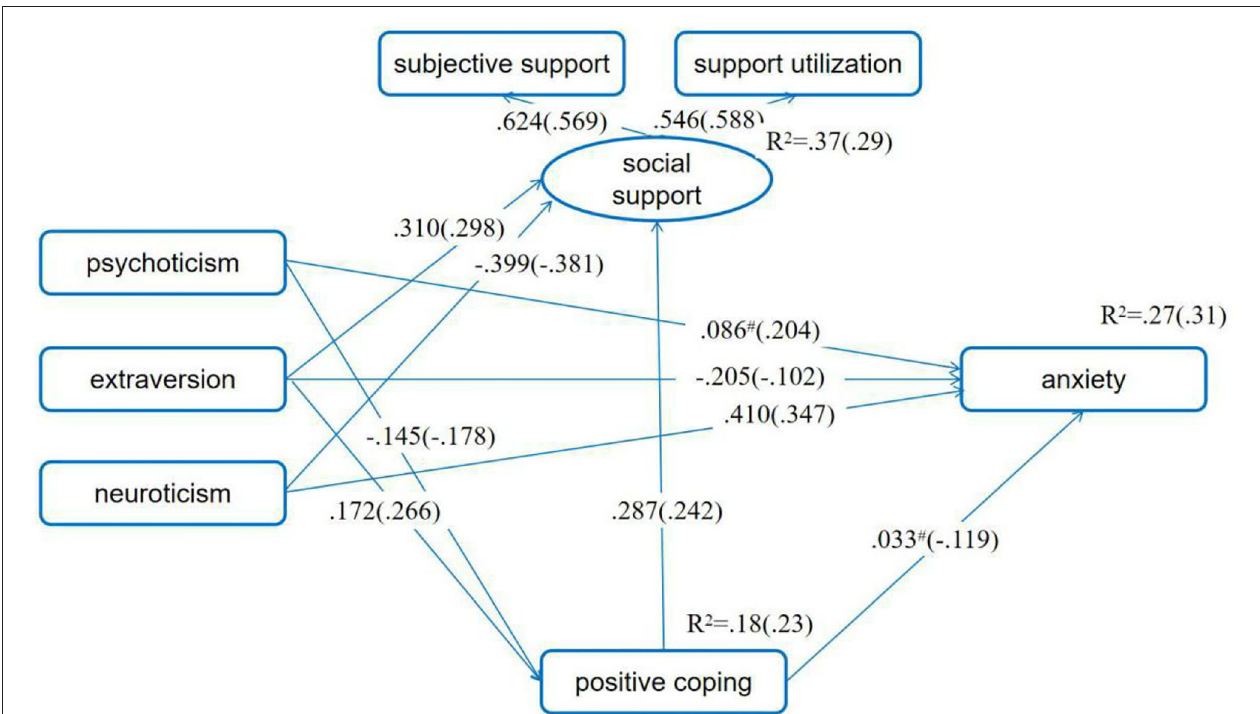
FIGURE 4 | SES as moderator in the mediating model of positive coping in the association between personality and anxiety symptoms. Standardized path coefficients before parentheses were for the low SES group, and those in the parentheses were for the high SES group. # p > 0.05, while the p -values for other standardized path coefficient were all < 0.05. The first pregnancy or not, having adverse pregnancy experience or not, being pregnant as planned or not, and number of weeks of pregnancy were set as control